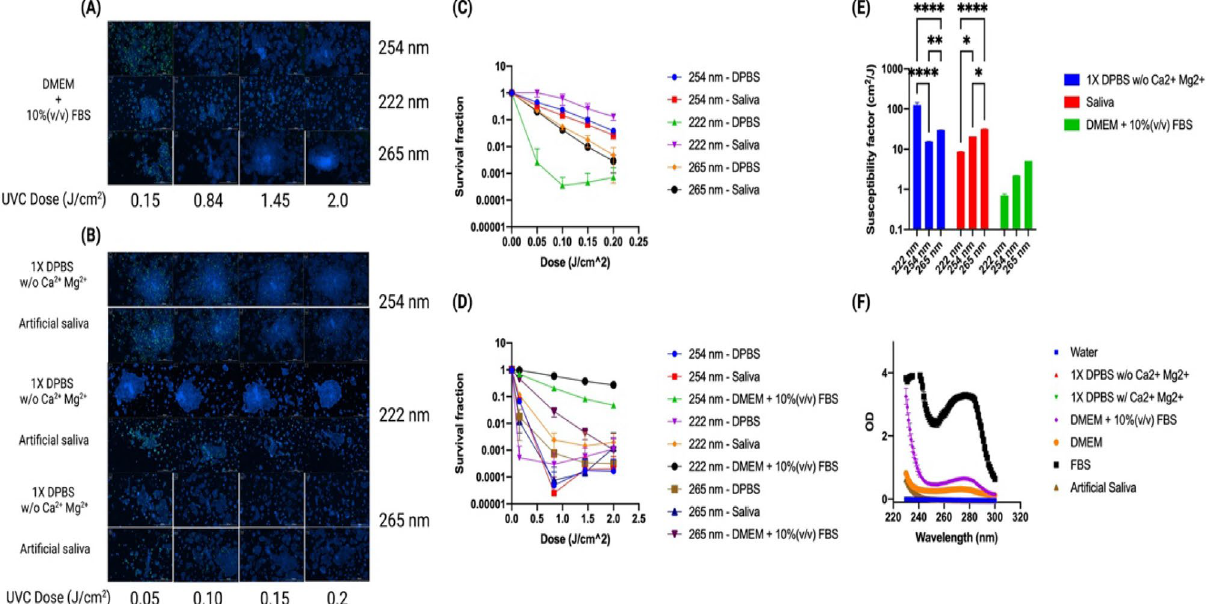
Figure 4. Lentiviral UVC susceptibility when being suspended in three different media. A portion of 300 µL of a lentivirus suspended in DPBS, an artificial saliva, or complete DMEM medium supplemented with 10%(v/v) FBS were exposed to various doses of 222, 254, or 265 nm UVC light. Lentivirus was exposed either to ( A ) 0.15–2 J/cm 2 in DMEM + 10%(v/v) FBS or a ( B ) lower dose range of 0.05–0.2 J/cm 2 before being used to infect HEK293-T cells. Cells were stained with a 1:2000 diluted Hoechst 33,342 at two days post infection. Scale bar: 1000 µm. Image analysis quantified the transduction efficiency of HEK293-T cultures for a ( C ) lower dose range and ( D ) the higher low dose range, and from these data ( E ) the susceptibility factors for lentivirus exposed to 222 nm, 254 nm, and 265 nm was calculated and compared. p value < 0.05. ( F ) Absorbance spectra of the three liquids showed DPBS absorbed both light sources negligibly across the 230–300 nm range. DMEM + 10%(v/v) FBS contains a secondary peak around 277 nm created by its components as well as the addition of the FBS itself. Error bars denote standard deviation. * p ≤ 0.05, ** p ≤ 0.01, *** p ≤ 0.001, **** p ≤